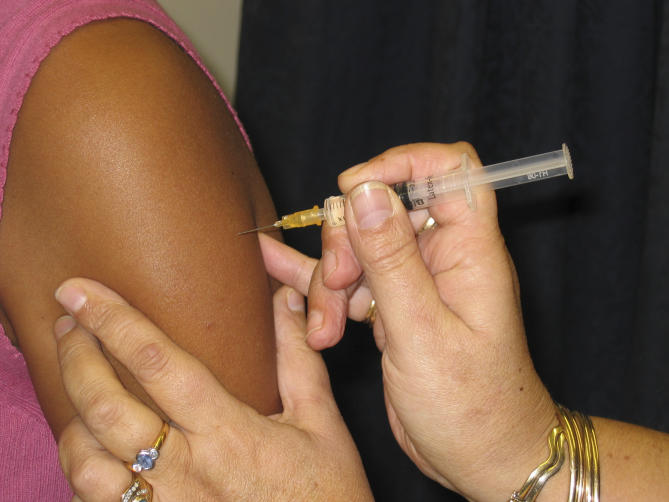
There is a high percentage of HOXB4GFP
+ cells early after transplantation